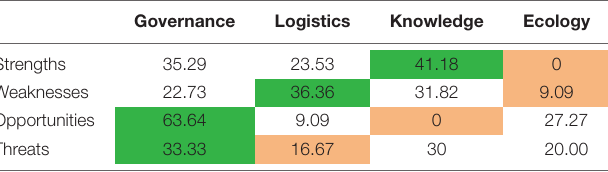
TABLE 3 | Percentage of statements that fell into each of the categories of Governance, Logistics, Knowledge, and Ecology and how these are distributed between the